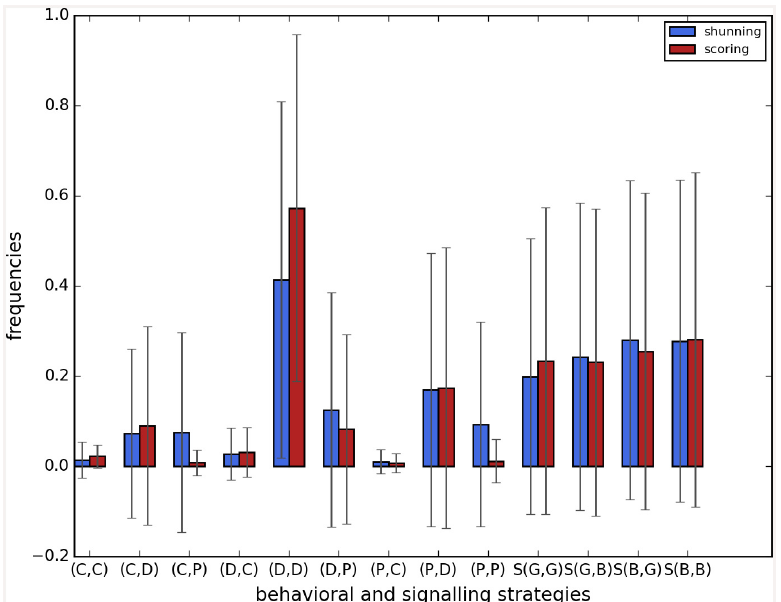
Fig 9. The frequencies of the behavioural and signalling strategies at the end of the simulations, BETA6. The figure shows the frequencies of the behavioural and signalling strategies at the end of the simulations. Each bar represents the average of 100 runs, error bars represent standard deviation, parameters are as follows: n = 100, c = 1, α = 1, β = 6, MST = 80%. The x axis shows the behavioral or signalling strategy, the y axis shows the average frequency of that strategy when runs were terminated.